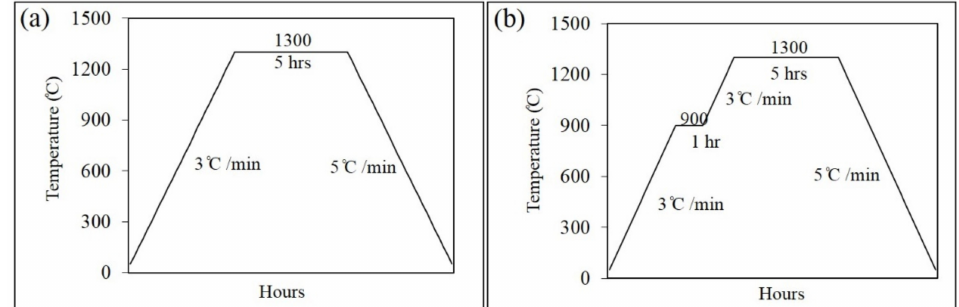
Figure 1. Sintering parameters for ( a ) Ti-HA(1) and ( b )